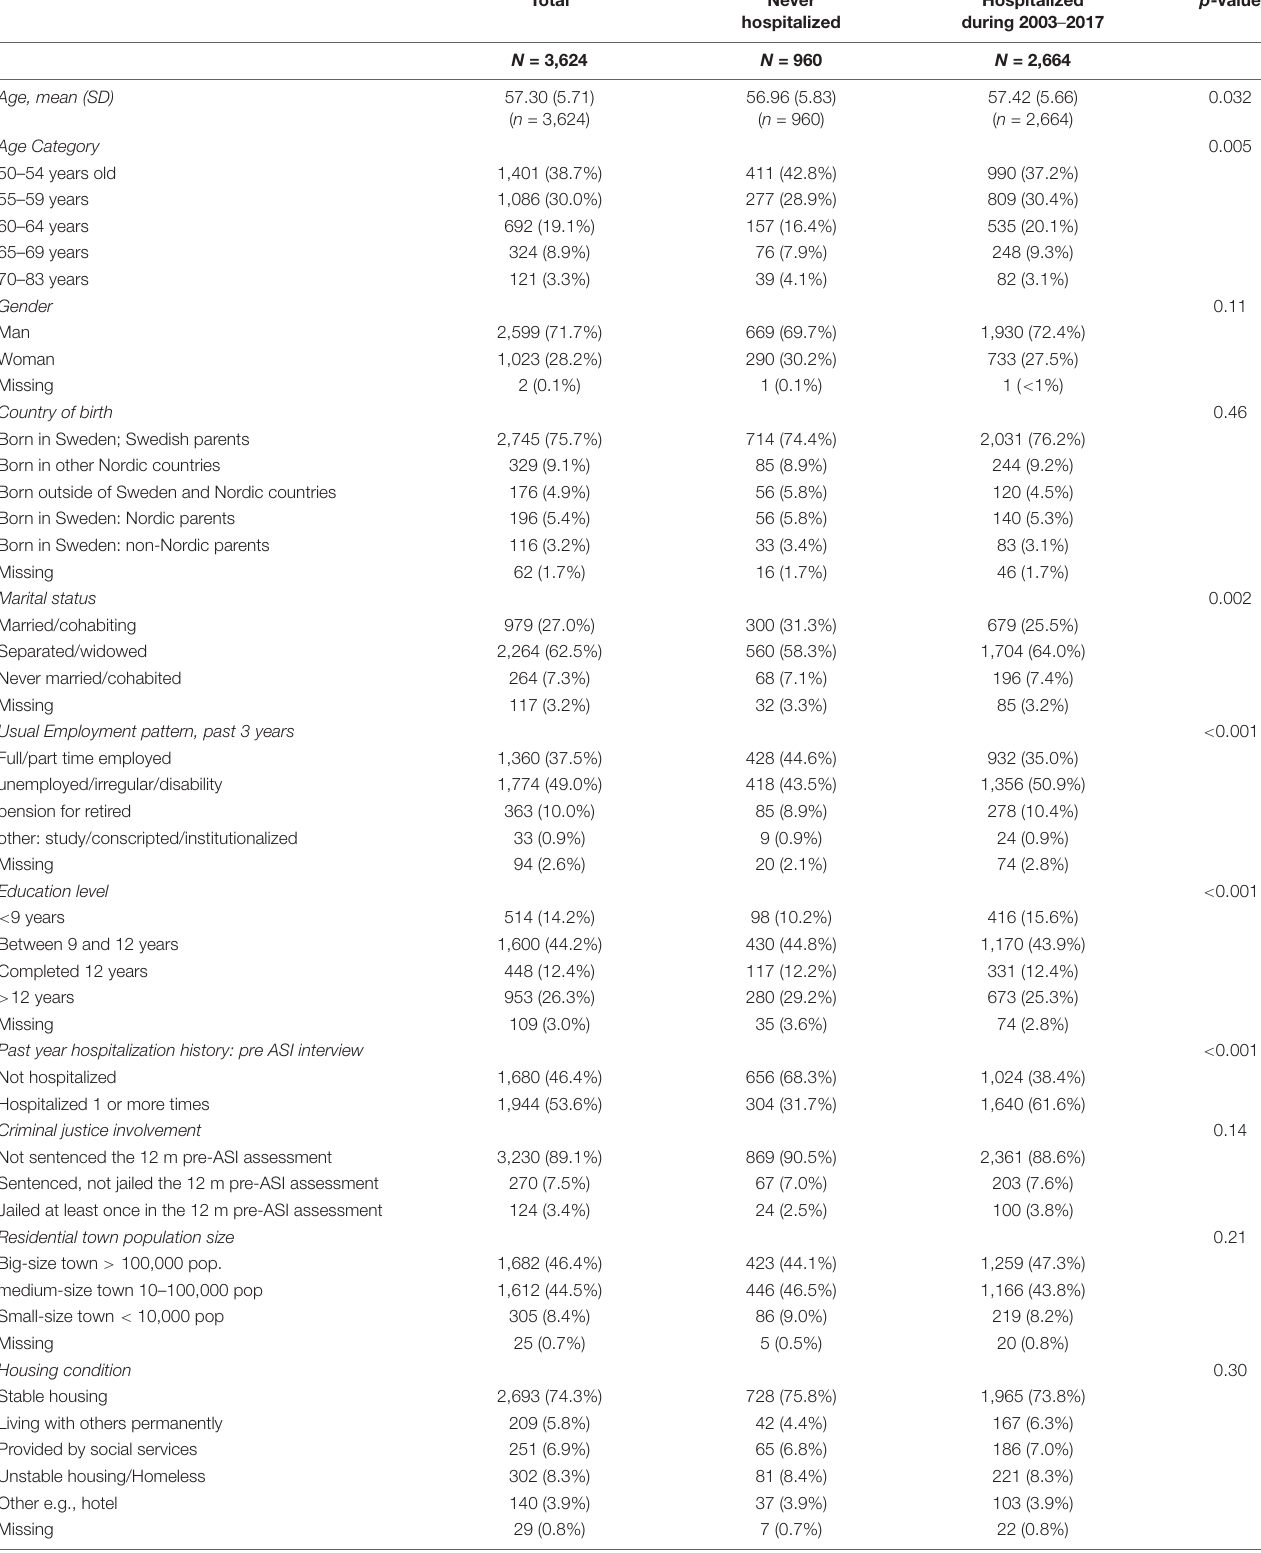
TABLE 1 | Baseline characteristics of the study population, those who were not hospitalized and those who were hospitalized one or more time between March 2003 and December